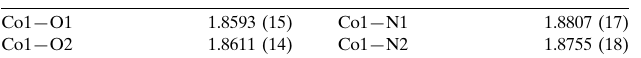
Rigaku Mercury diffractometer Absorption correction: multi-scan